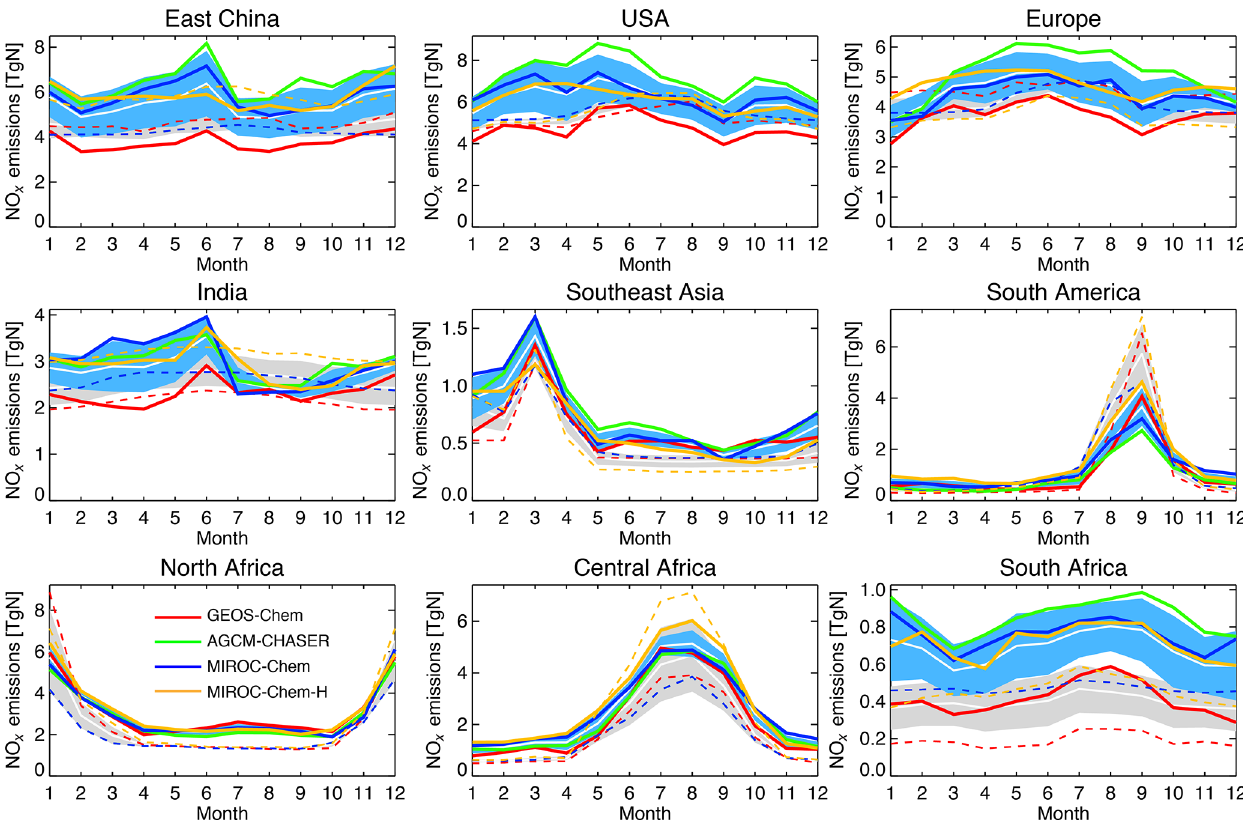
Figure 18. Time series of monthly total regional surface NO x emissions (TgNyr − 1 ) obtained from the a priori emissions (dotted lines) and the a posteriori emissions (solid lines) for 2007 for the four systems. AGCM-CHASER and MIROC-Chem use the same a priori emissions. The ± 1 σ deviation among the four models (i.e., model spread) is shown in gray for the control runs and in light blue for the data assimilation